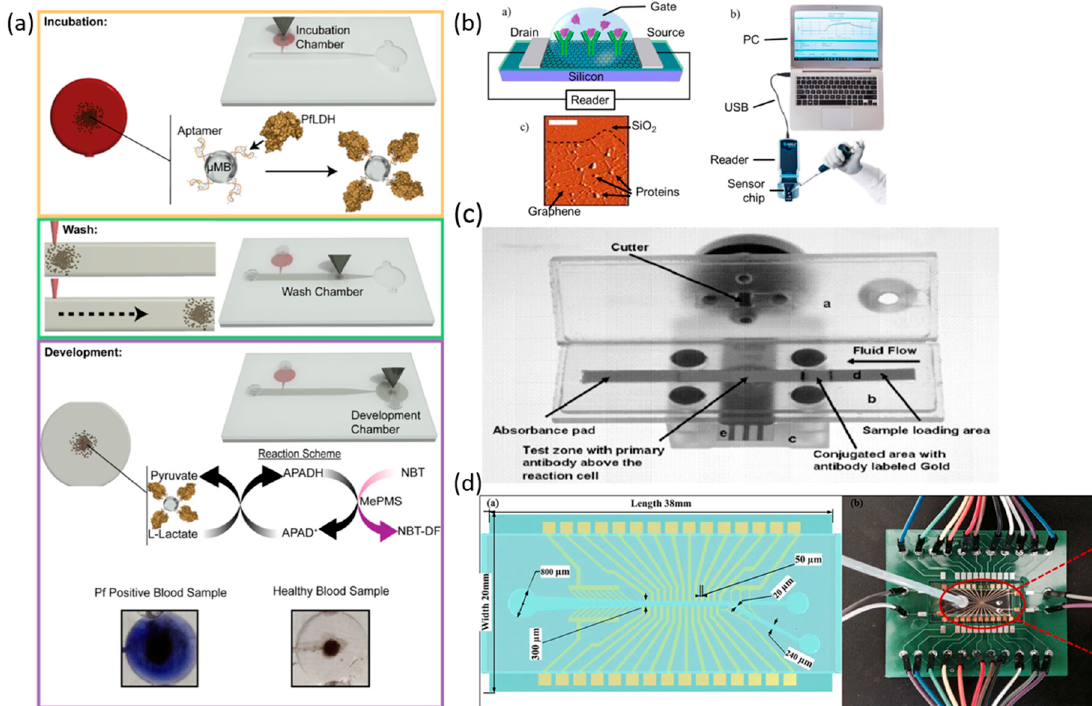
Figure 5. Portable biosensors for blood biomarker detection. ( a ) Operation and detection stages of the microfluidic APTEC biosensor [42]. ( b ) Diagram of the sensor element of the graphene biosensor chip